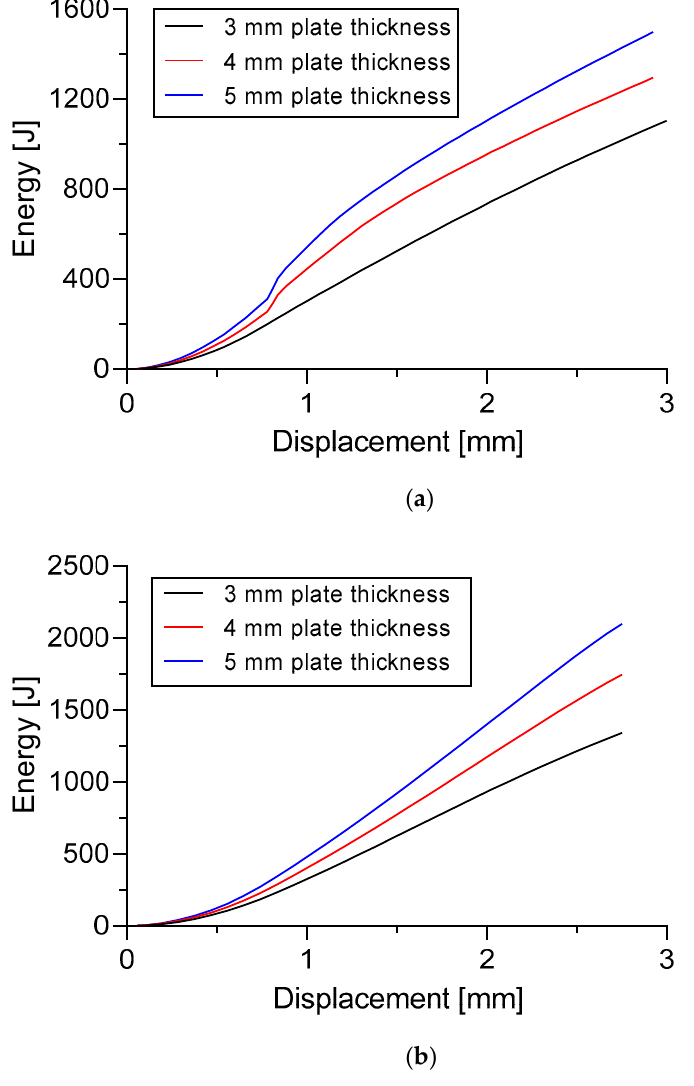
Figure 19. Effect of thickness change to energy versus displacement curve. ( a ) Specimen A; ( b ) Specimen